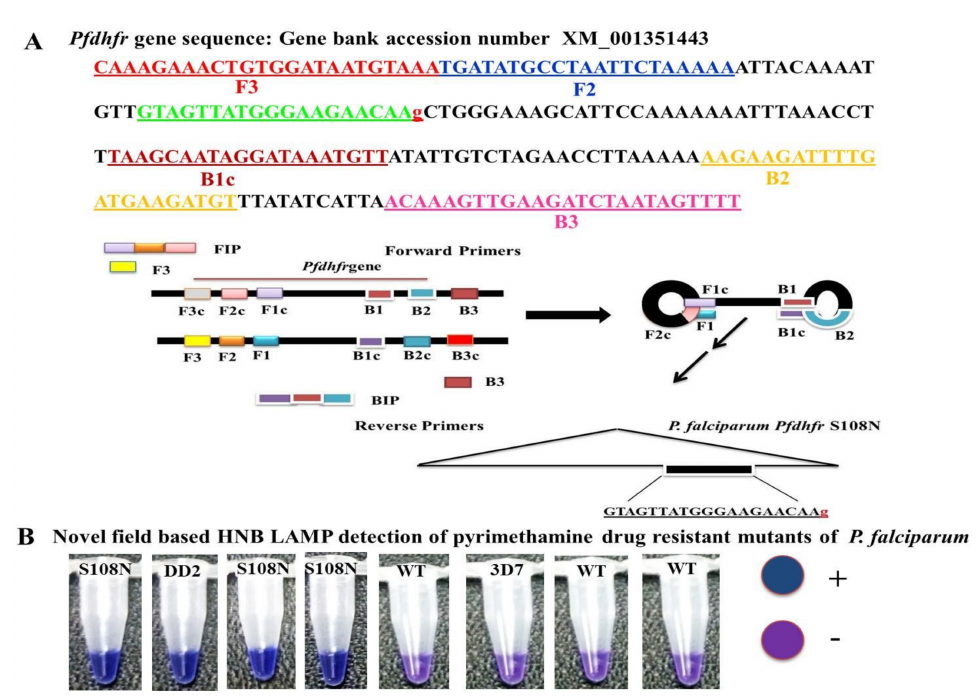
Figure 1. Sequence alignment of Pfdhfr gene and diagrammatic representation of loop primers used in the study and simple hydroxynaphthol blue (HNB) based single nucleotide polymorphism loop-mediated isothermal amplification (SNP–LAMP) detection of S108N mutants of P. falciparum . ( A ) Nucleotide sequence alignment of the Pfdhfr gene target region: Sequences of Pfdhfr gene primers F3, B3, FIP, and BIP used in the SNP–LAMP assay. Single point mutation shown by red small letter (S108N AGC → AAC) inserted in forward inner primer (FIP) allied with pyrimethamine-resistant P. falciparum malaria. Sites of primer binding region in the reference sequence (Pf; Gene bank accession no. XM_001351443) was indicated by underlines. Schematic representation of the Pfdhfr gene loop